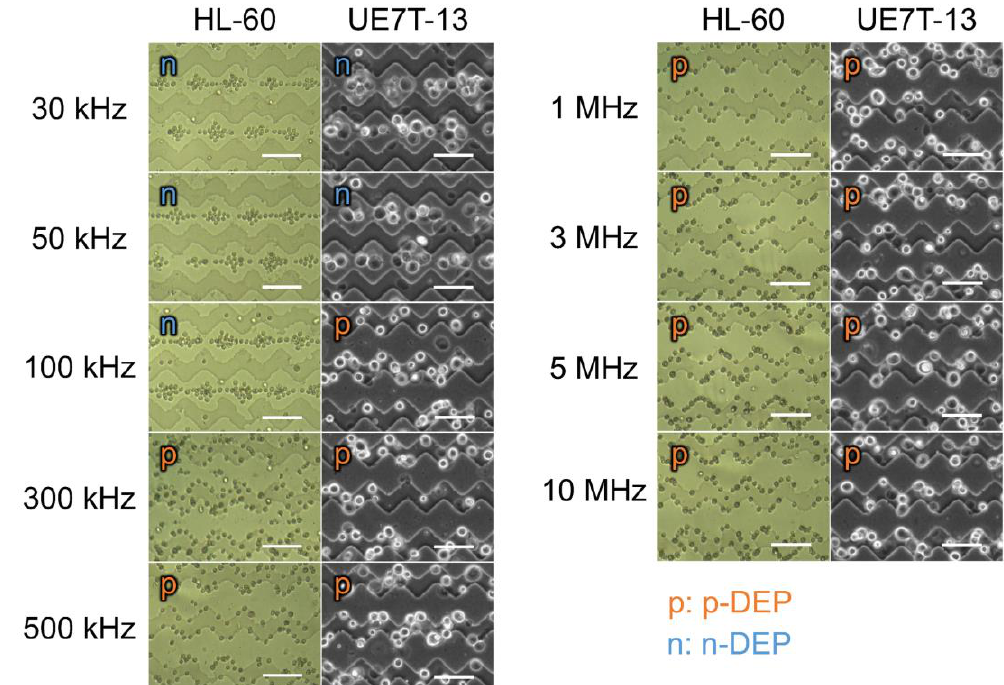
Figure 2. Microscopic images of cell dielectric responses at various frequencies. DEP behaviors of the HL-60 and UE7T-13 cells on the saw-shaped electrodes at 20 V peak-to-peak (Vpp) at various frequencies. The concentrations of the UE7T-13 and HL-60 cells were 1.0 × 10 7 cells/mL, and the images of these cells were obtained by bright field and phase contrast microscopy, respectively. Scale bars represent 100 μm.